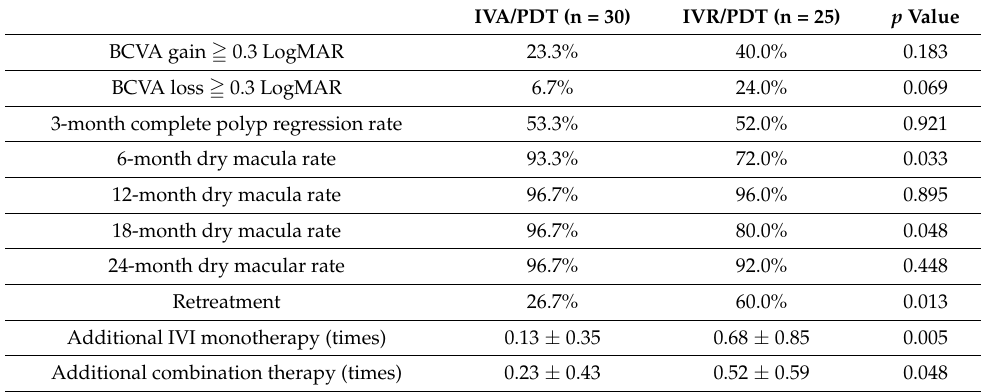
Table 2. Outcome and retreatment comparison between two